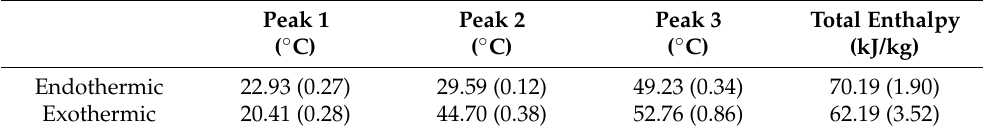
Table 4. Endothermic and exothermic transitions peaks and total enthalpy (SD between brackets). Peak 1 ( ◦ C)